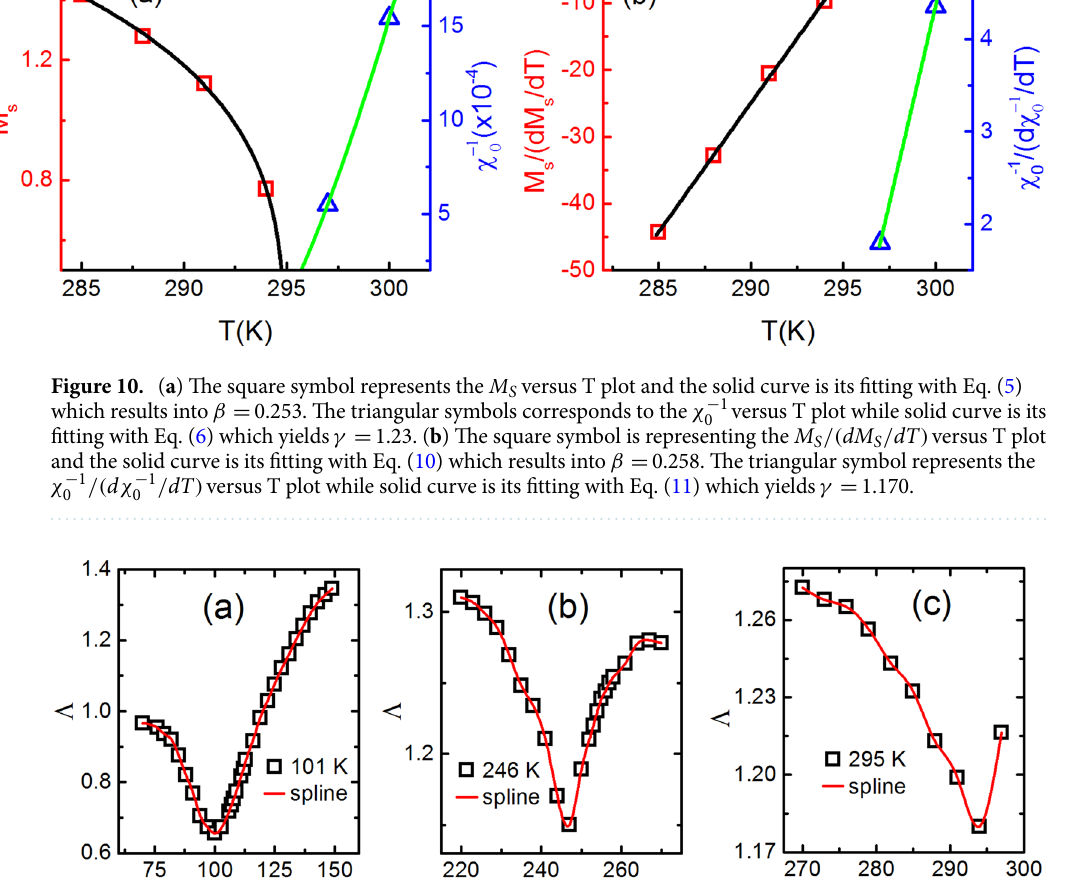
Figure 11. (cid:31) versus T plots at T C 1 , T C 2 and T C 3 : ( a ) The black rectangle is (cid:31) versus T plot around 101 K in the temperature range 70–150 K and the red curve is the spline for eye guide. ( b ) The black rectangle is (cid:31) versus T plot around 246 K in the temperature range 220–270 K and the red curve is the spline for eye guide. ( c ) The black rectangle is (cid:31) versus T plot around 295 K in the temperature range 270–297 K and the red curve is the spline fit guide to the